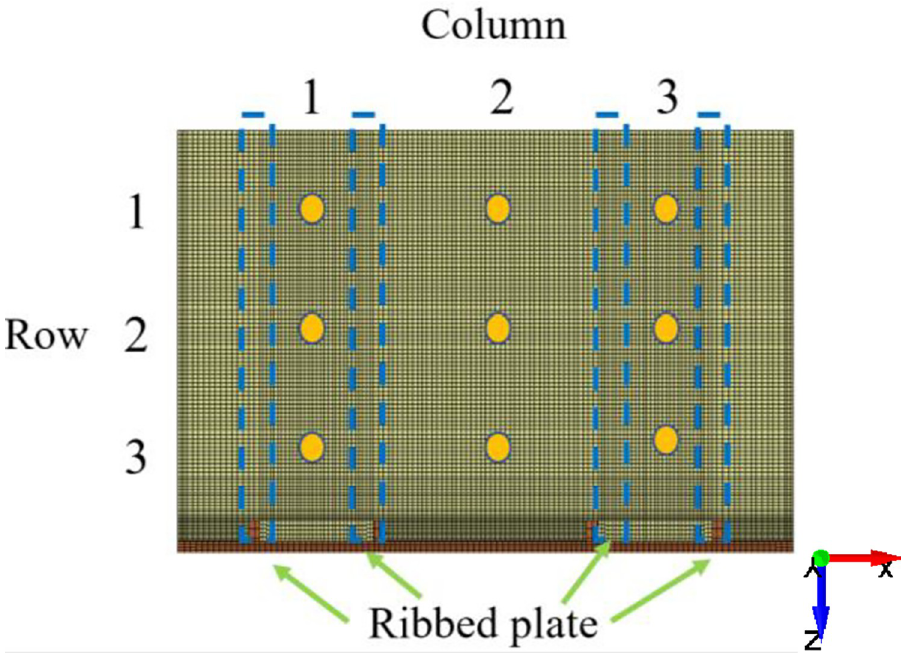
Fig 9. Nine nodes on the tail